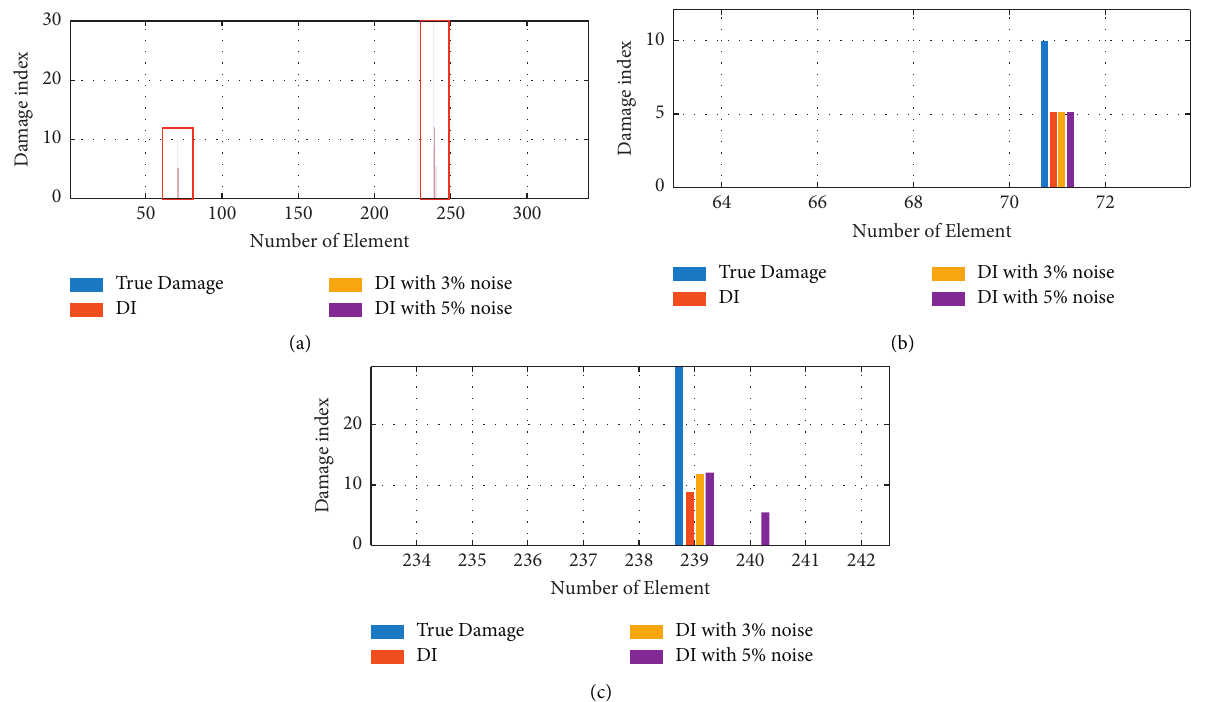
Figure 16: Results of multiple-damage scenario D5 containing measurement noise. (a) Original result. (b) Zoomed result part 1. (c) Zoomed result part